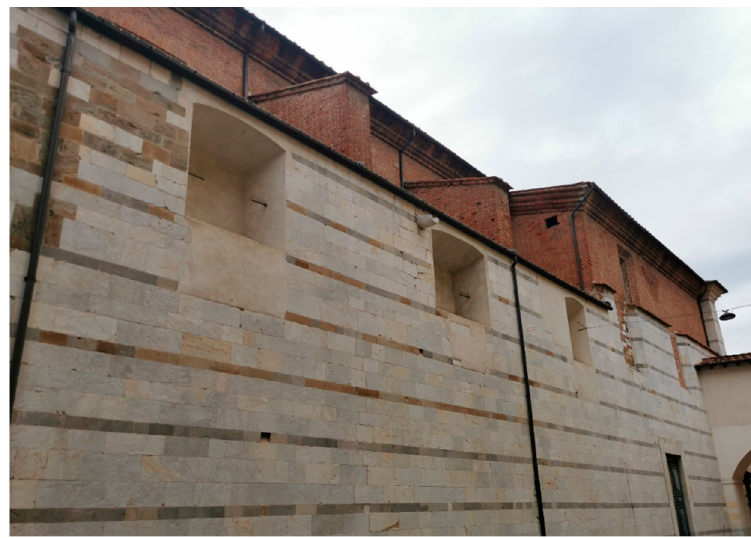
Figure 13. The south wall of St. Nicola Church.